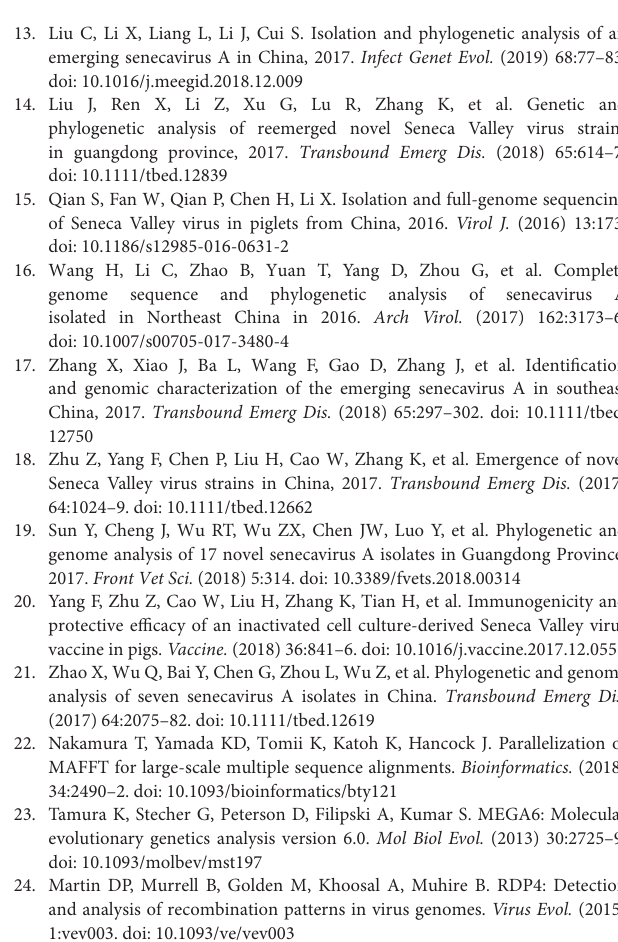
Figure S1 | Representative images of cytopathic effects and immunofluorescence assay. PK-15 cells infected with SVA HeNNY-1/2018, HeZMD-1/2018, and HeNKF-1/2018 strains at 18h post-infection. Cells were stained with primary antibody of porcine SVA positive serum. Table S1 | Sequence information in this study. Table S2 | The recombination events detected by RDP4.0 after complete genome sequence alignment of SVA